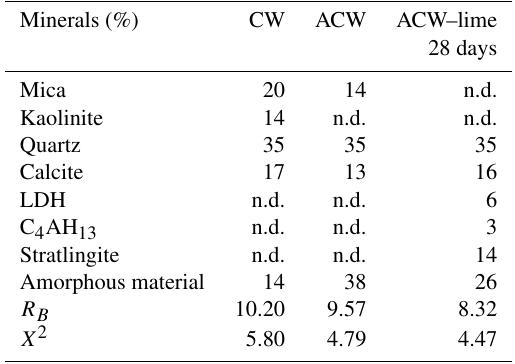
Table 1. Mineralogical composition by XRD of products from coal mining (CW, ACW and after 28 days of reaction in the ACW–lime system).